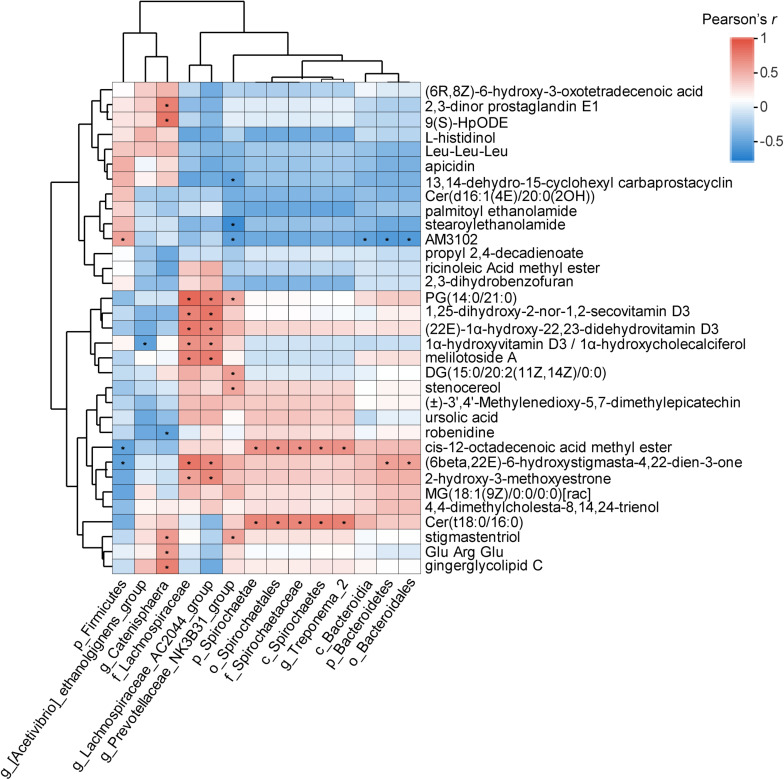
Correlation analysis between the significantly differential metabolites and fecal bacterial taxa identified by LEfSe according to Pearson’s r for fecal metabolite types and bacterial taxa (*P < 0.05). Red represents a positive correlation, while blue represents a negative correlation.